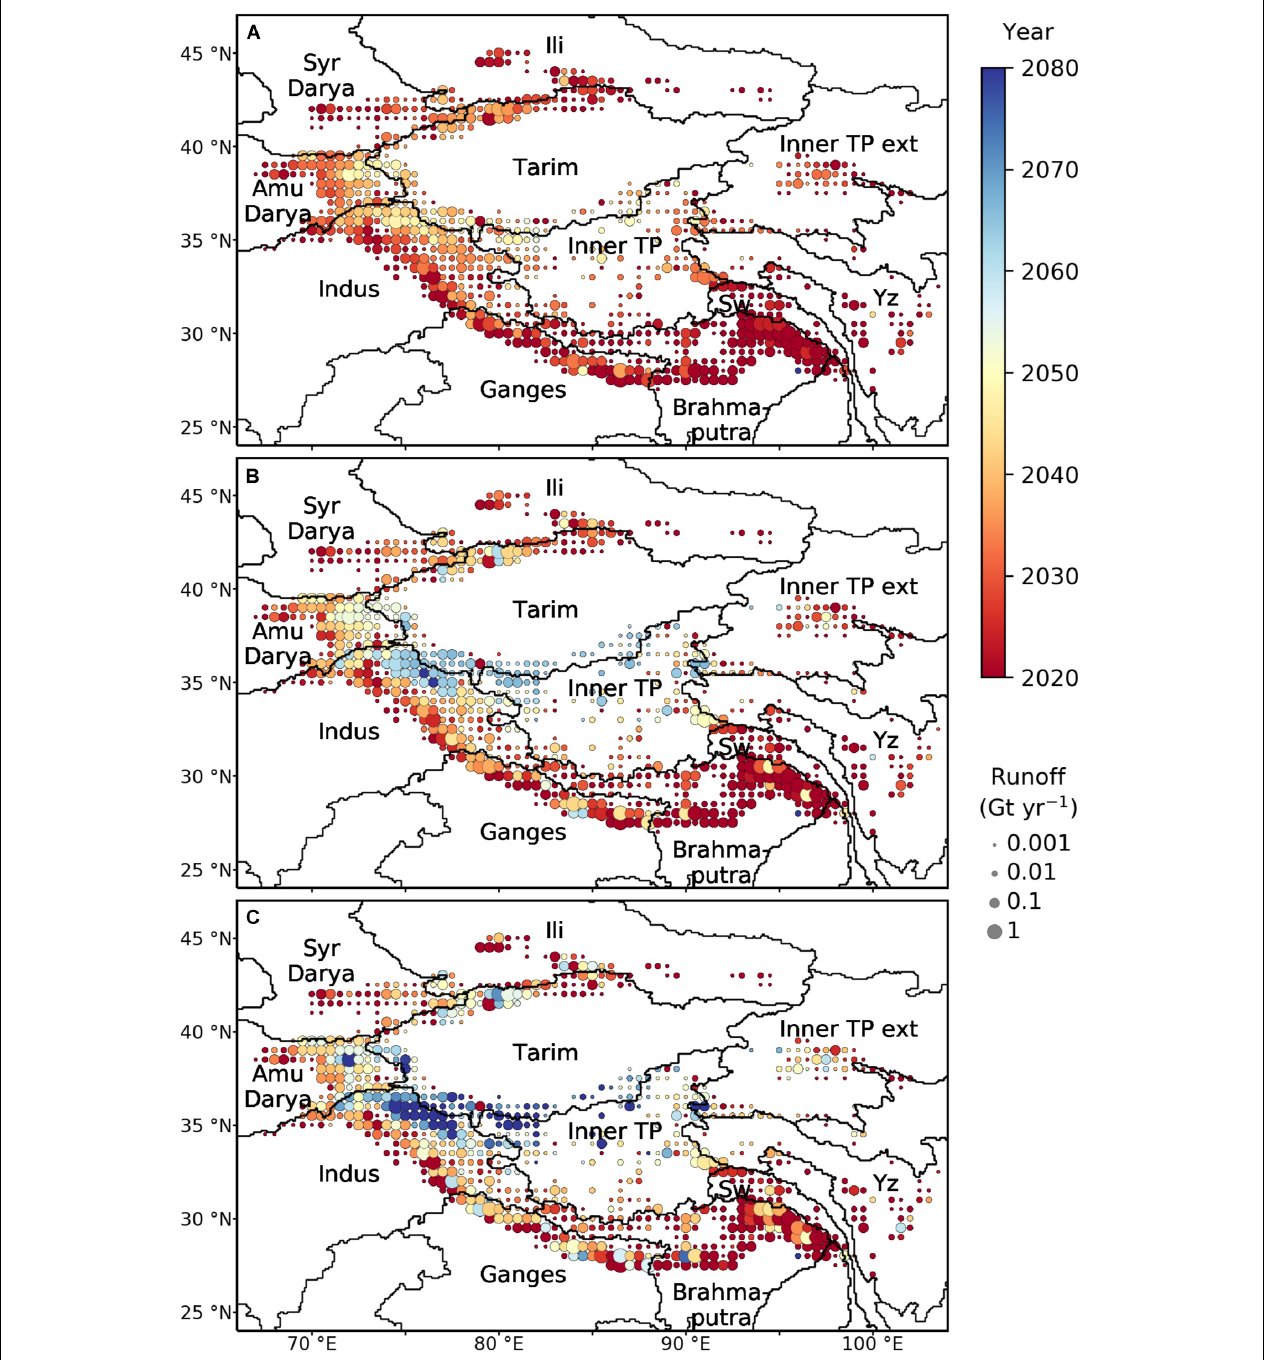
FIGURE 7 | Spatial distribution of peak water (i.e., the year of maximum annual fixed-gauge glacier runoff) aggregated by 0.5 ◦ grid cells for (A) RCP 2.6, (B) RCP 4.5, and (C) RCP 8.5. The circles are scaled by the multi-GCM mean annual glacier runoff (Gt yr - 1 ) from 2000 to 2015 within the cell. Major river basins are shown (Sw, Salween; TP, Tibetan Plateau; Yz,